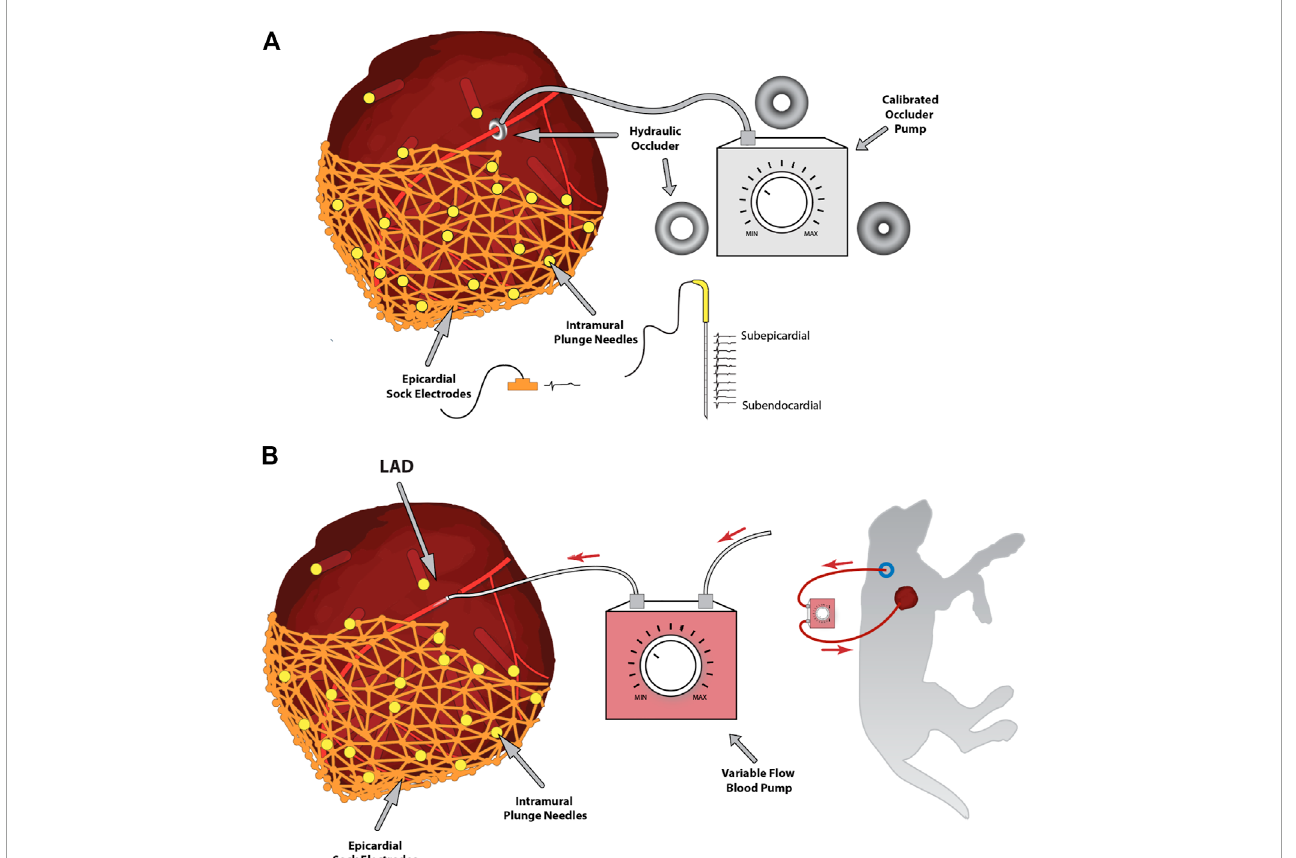
FIGURE 1 Experimental approaches to controlling coronary blood flow. Panel (A) shows the hydraulic occlusion device placed around the left anterior descending coronary artery and controlled via an external calibrated hydraulic pump. Also, note the intramural and epicardial electrical recording arrays, including samples of recorded signals. Panel (B) shows an alternative approach of a controlled-flow blood pump connecting a carotid artery to the left anterior descending coronary artery to control blood flow downstream of the